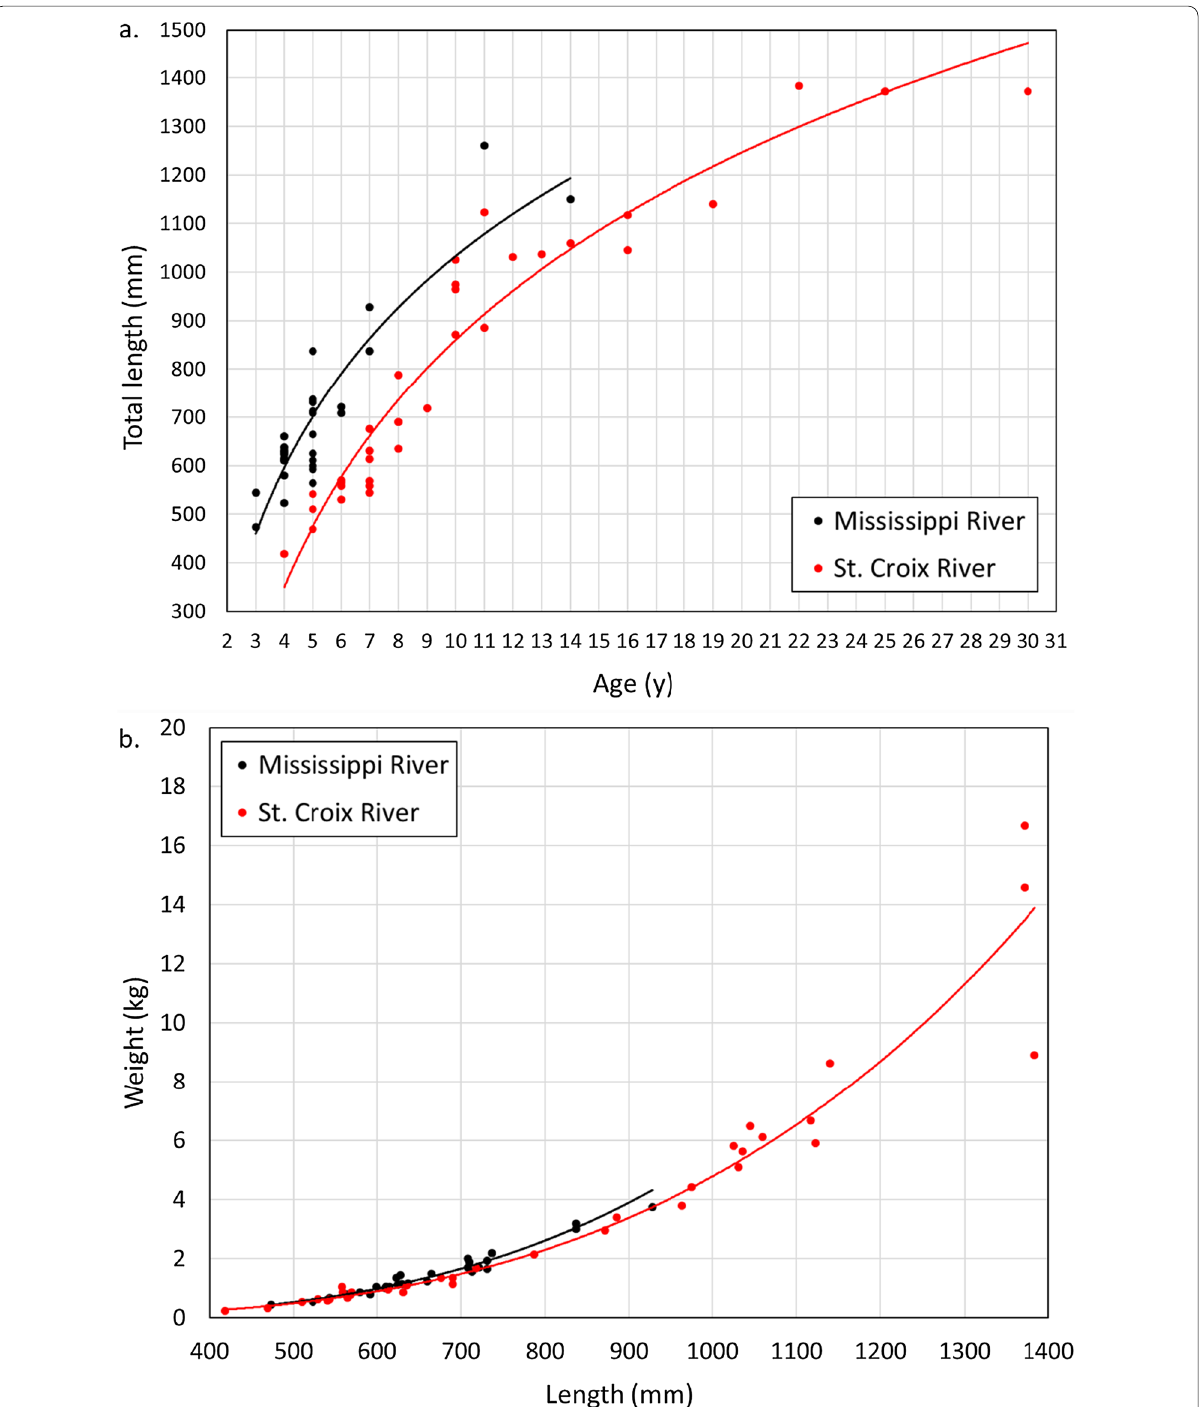
Fig. 4 Age-length ( a ) and length–weight ( b ) relations for sample populations (all ages) of lake sturgeon captured in the Mississippi and St. Croix Rivers. a Logarithmic trendlines for each river, and b power trendlines for each